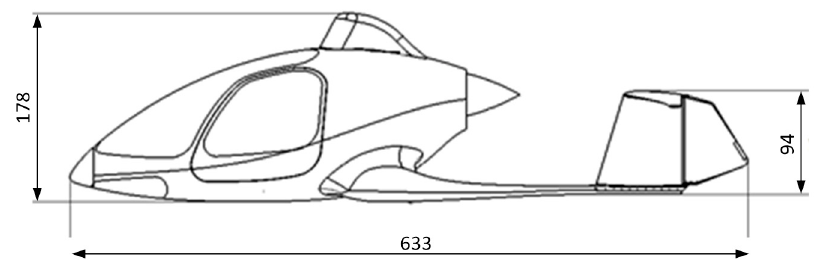
Figure 4. Taifun gyroplane-geometrical dimensions (mm) of the object (view from the left).